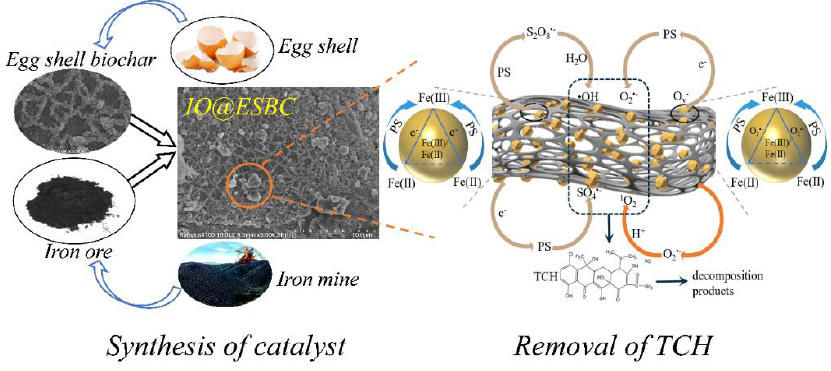
Figure 4. The proposed mechanism diagram in IO@ESBC/PS/TCH system.